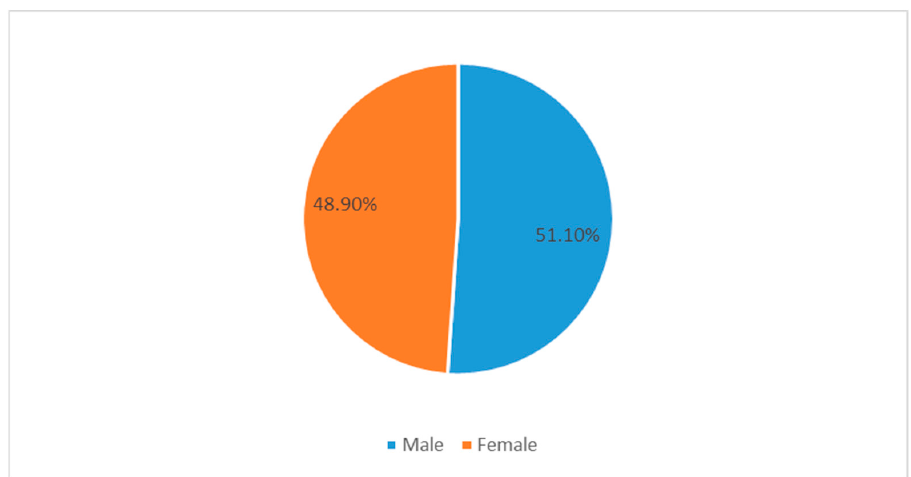
Figure 1. Pie chart for the gender distribution of respondents.